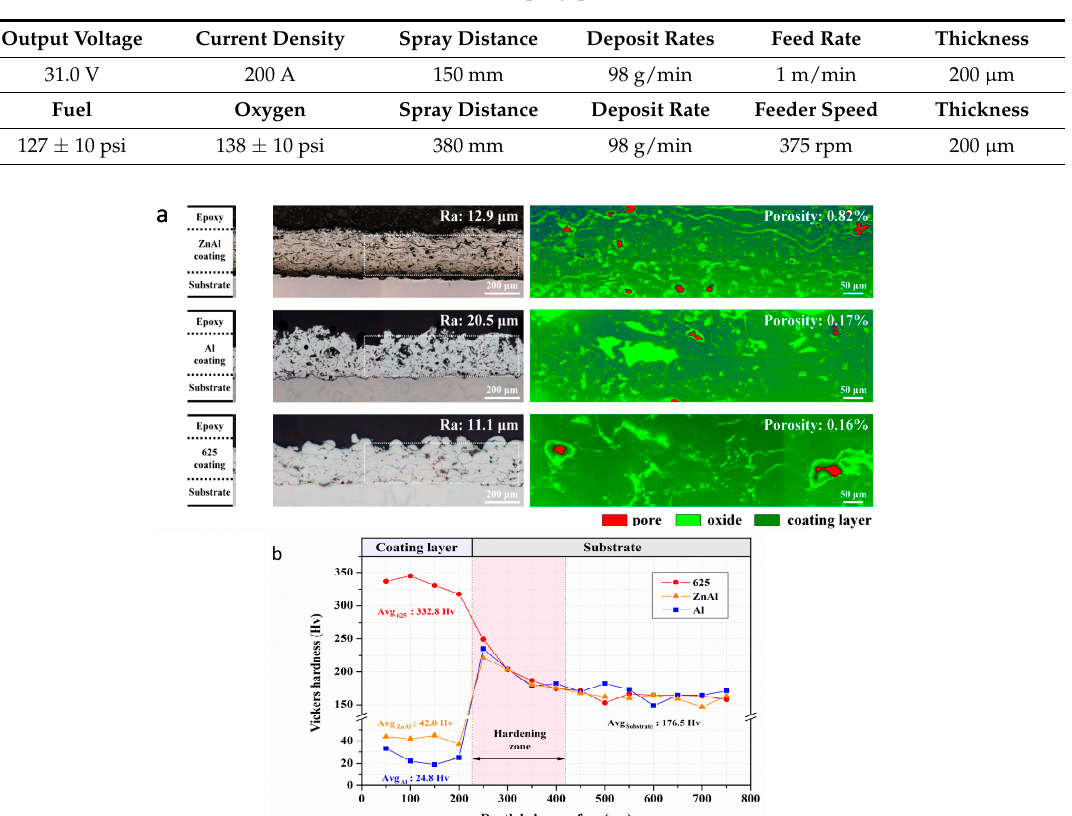
Table 2. Thermal spray parameters.